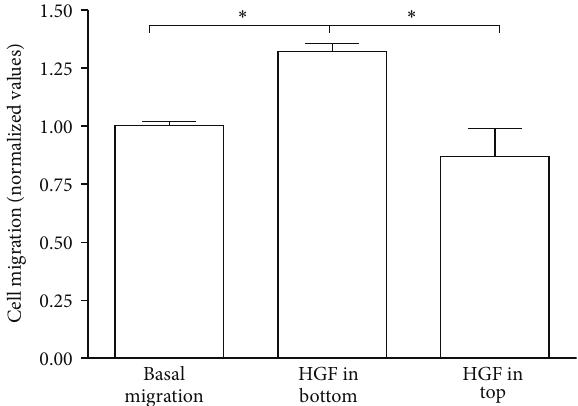
Figure 6: Boyden chamber assay with HGF in top compartment only. Values compared to basal migration and HGF in bottom compartment only. 𝑛 = 2 . ∗ 𝑃 < 0.05 .